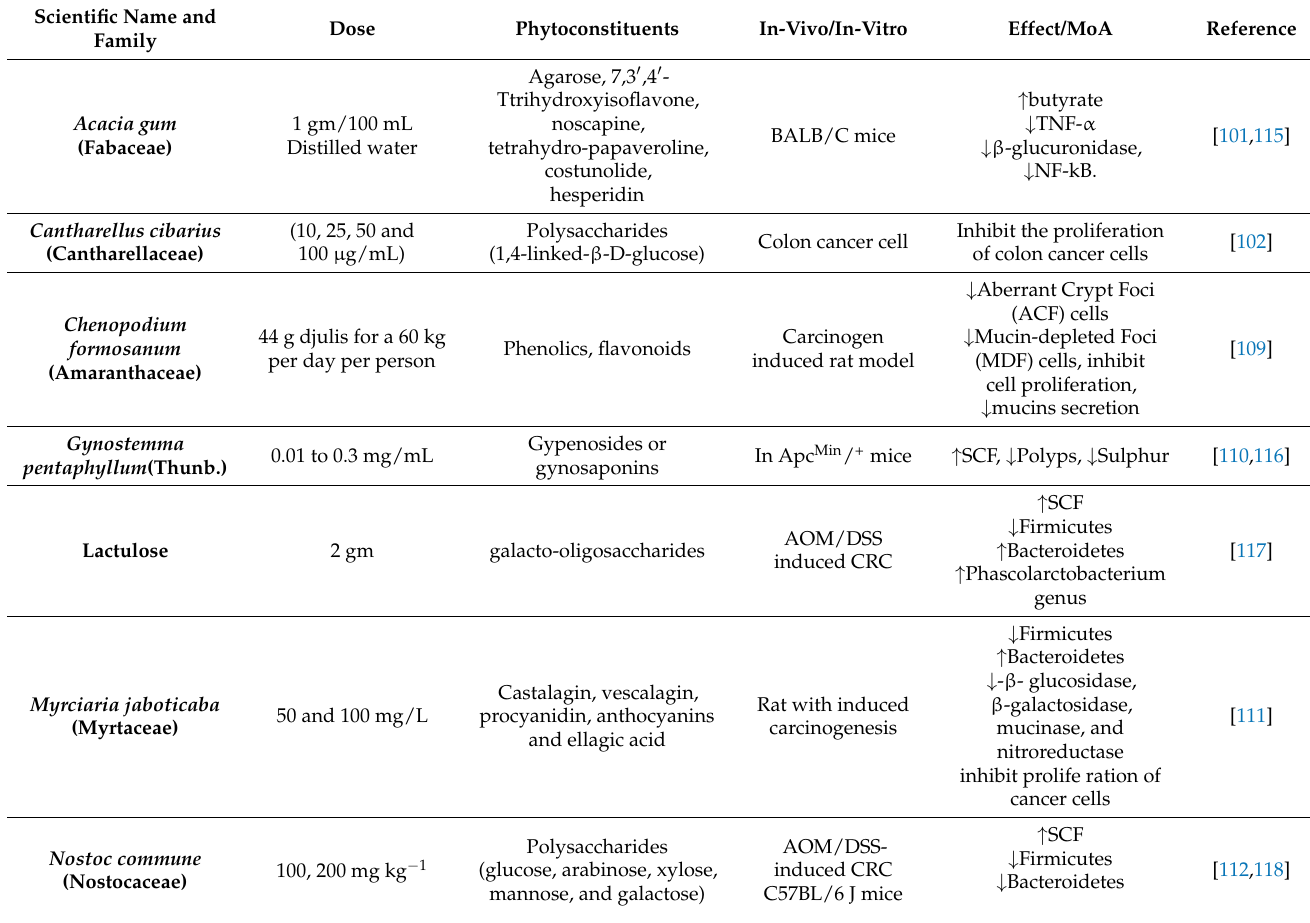
Table 2. In vivo and in vitro anti colon cancer studies on various dietary fibres and their